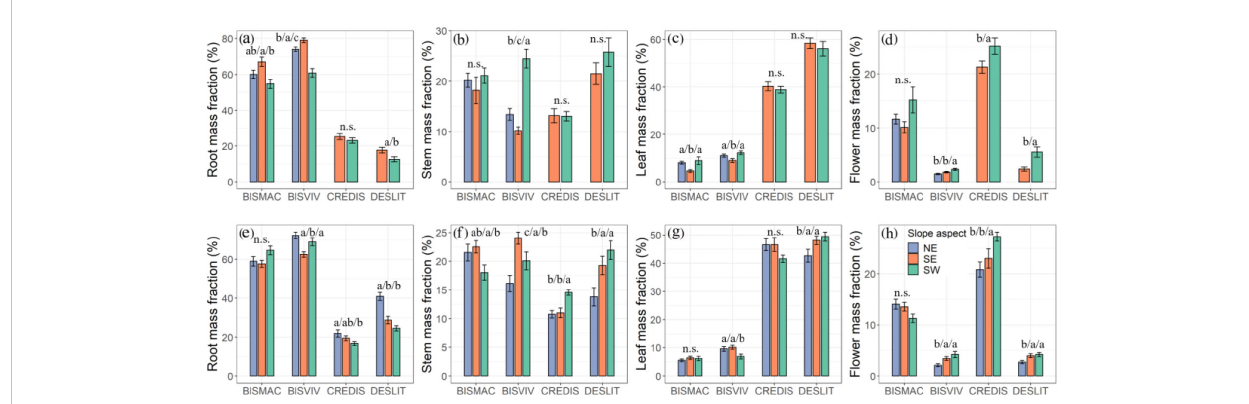
FIGURE 4 Effect of slope aspect on mass fraction at different organs at mountain A (A – D) and mountain B (E – H) . NE, SE, and SW refer to northeast, southeast, and southwest slope aspects, respectively. Letters indicate signi fi cant differences (n.s., not signi fi cant). Values are mean ± SE. BISMAC, BISVIV, CREDIS, and DESLIT are the abbreviation of Bistorta macrophylla , Bistorta vivipara , Cremanthodium discoideum , and Deschampsia littoralis ,